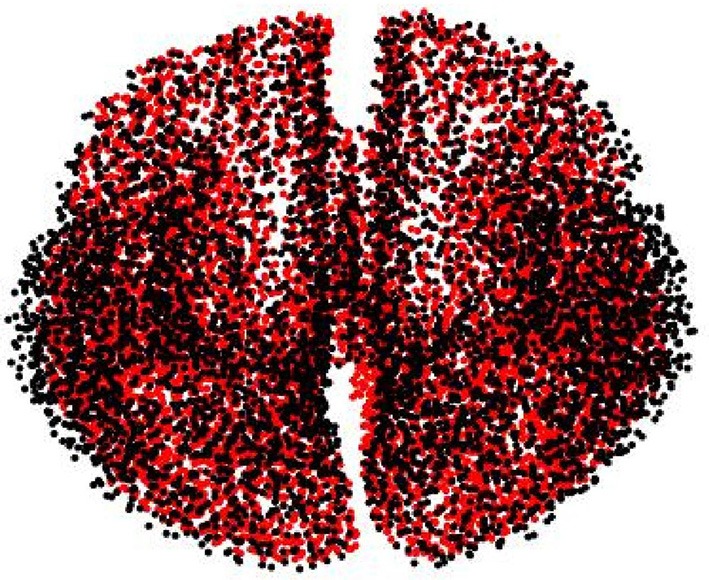
Used meshes for simulating (black dots) and reconstructing (red dots) brain activity to avoid the inverse crime.